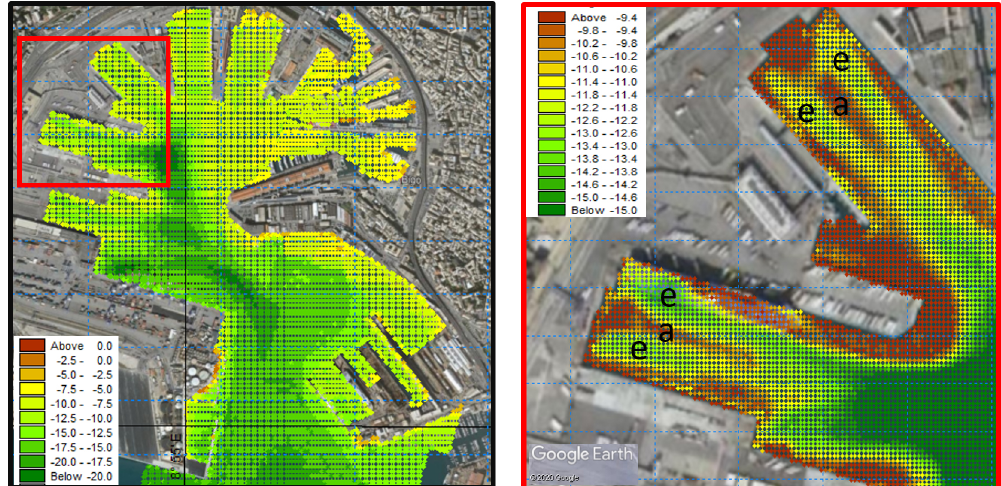
Figure 3. Bathymetry of the port of Genoa. Entire passenger port (left panel) and a zoom in of Ponte Colombo and the surrounding basins (T5–T11, right panel). Land background from © Google